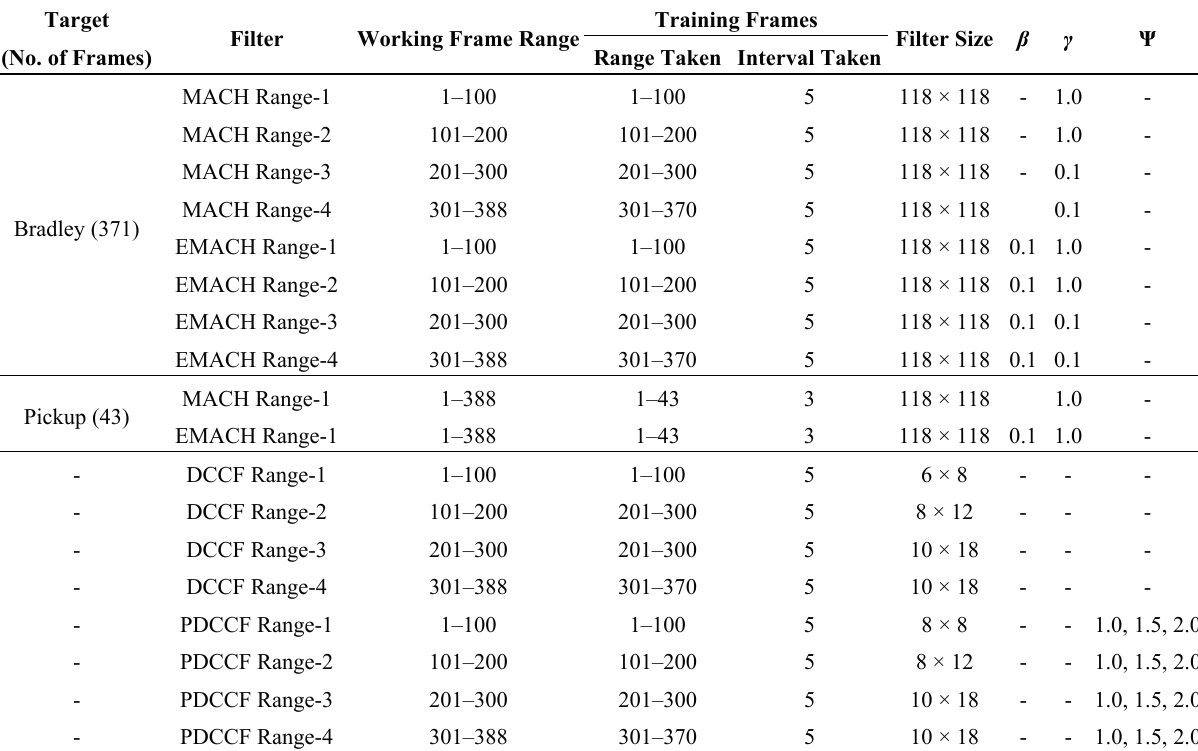
Table 6. Training data for Sequence L1701.